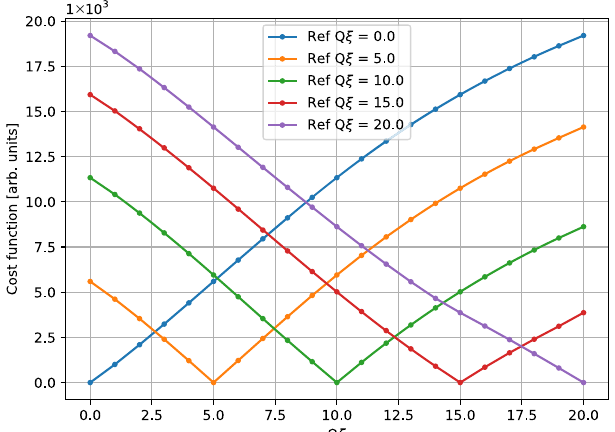
FIG. 11. Difference between spectra of a typical LHC bunch for different values of chromaticity expressed in terms of cost function